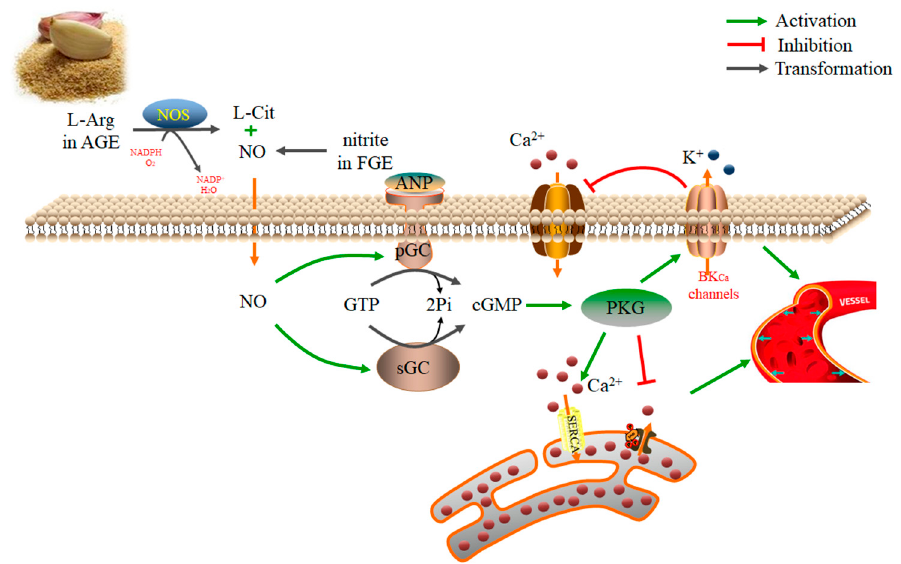
Figure 2. The mechanisms of the antihypertensive properties of garlic extract via increasing the production of nitric oxide (NO) in vascular smooth muscle cells. The l -arginine (L-Arg) in aged garlic extract (AGE) could be transformed into NO and L-citruline (L-Cit) mediated by nitric oxide synthase (NOS). Moreover, the nitrite in the fermented garlic extract (FGE) could be converted into NO in vivo by Bacillus subtilis . NO and atrial natriuretic peptide (ANP) activated particulate guanylyl cyclase (pGC) and soluble guanylyl cyclase (sGC), thus catalyzing the transform of guanosine triphosphate (GTP) to cyclic guanosine monophosphate (cGMP). The elevated cGMP activated PKG, and PKG decreased intracellular Ca 2 + concentration by increasing intracytoplasmic Ca 2 + transport into the sarcoplasmic reticulum through the sarco / endoplasmic reticulum Ca 2 + -ATPase (SERCA) pathway, thereby preventing the release of Ca 2 + from the sarcoplasmic reticulum to the cytoplasm, and stimulating the Ca 2 + -activated K + (BK Ca ) channel on the cell membrane, as well as reducing the Ca 2 + influx. As a result, the vascular smooth muscle relaxed, and the blood vessels dilated.